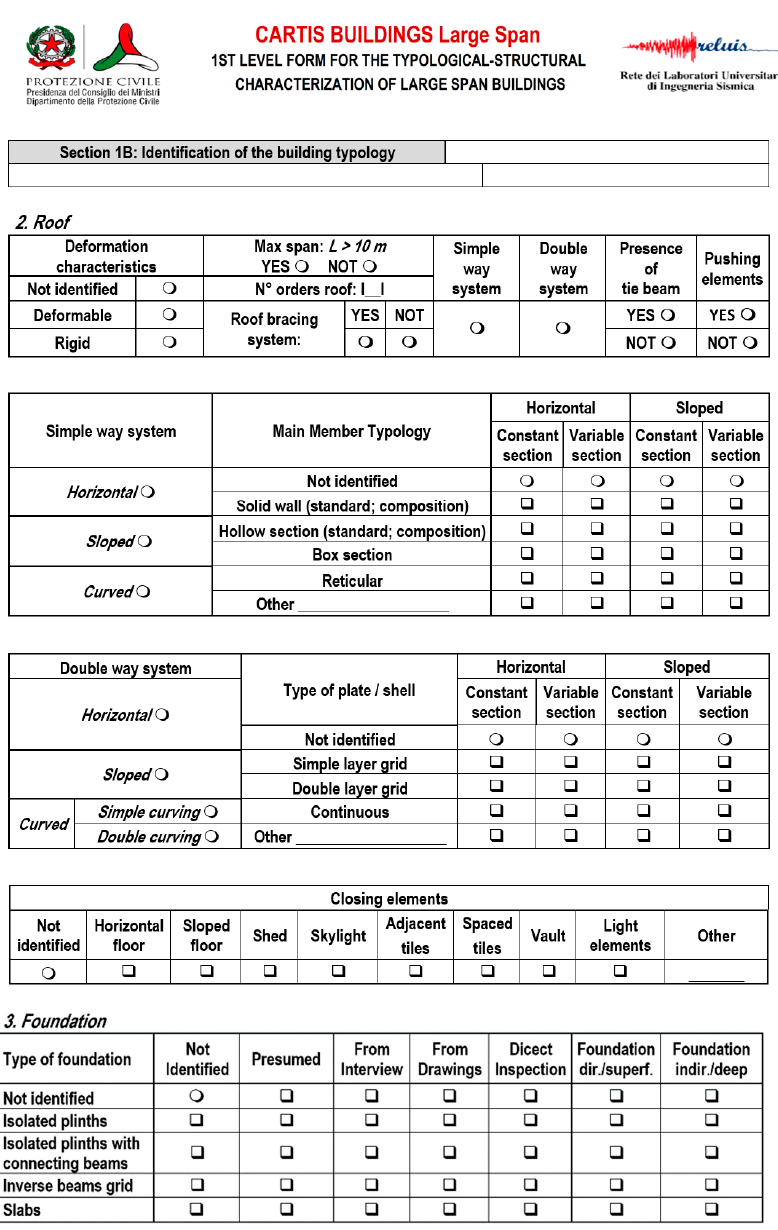
Figure 11. Section 1B CARTIS-Building: Identification of the building typology (English version [19]).